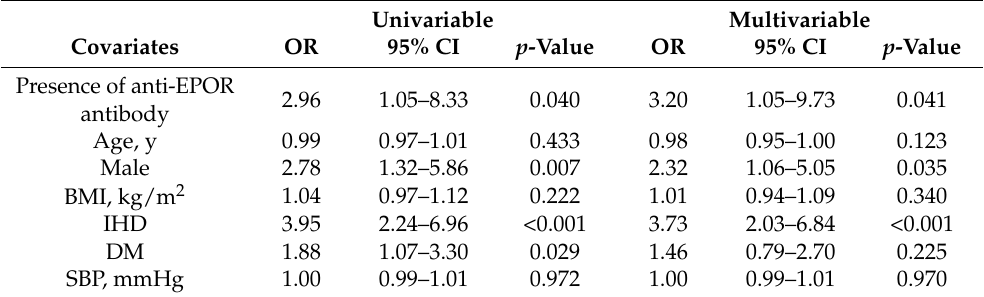
Table 4. Univariable and multivariable logistic regression analysis for reduced ejection fraction (LVEF < 50%).